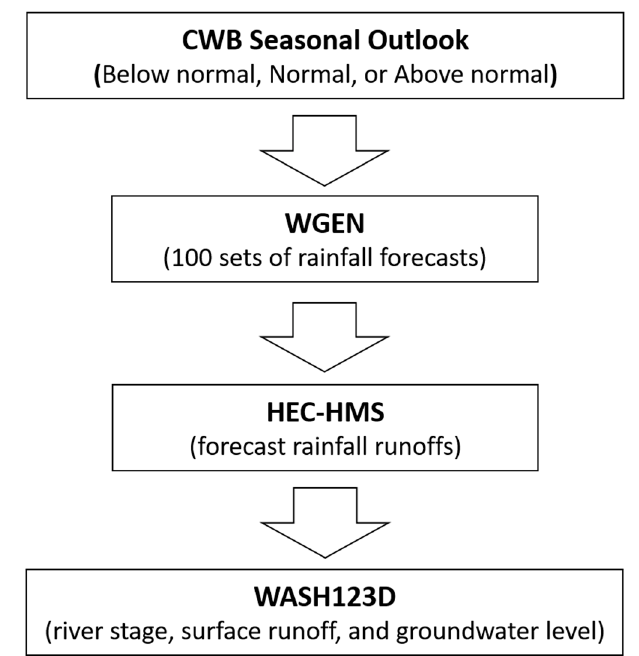
Figure 1. Flowchart of the proposed method. CWB, Central Weather Bureau of Taiwan; WGEN, weather generator; HEC-HMS, hydrologic modeling system; WASH123D, watershed systems of one-dimensional (1D) stream–river network, 2D overland regime, and 3D subsurface media.